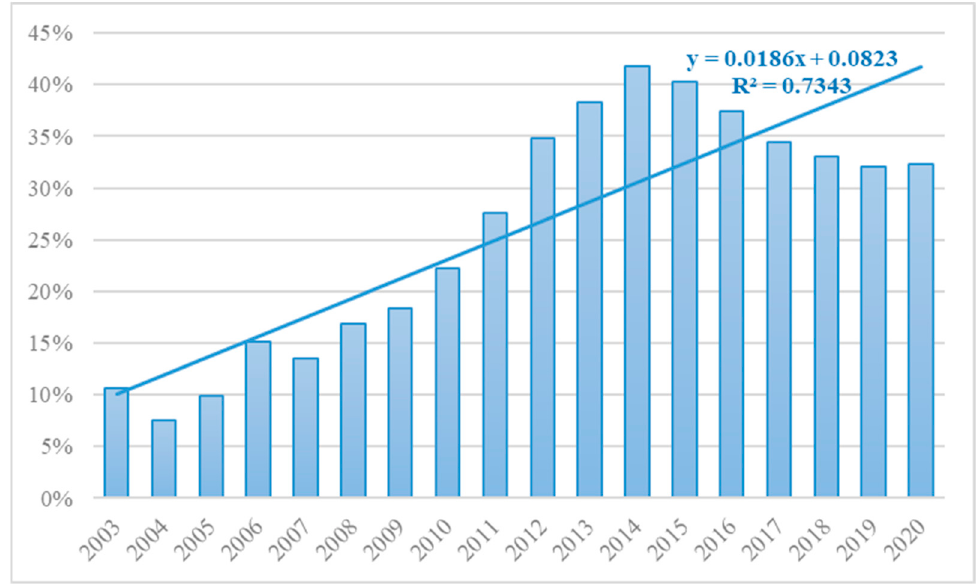
Figure 6. Ratio of liabilities to the annual budget revenues for 2003–2020 (in %) for the city of Bytom. Source: own elaboration.